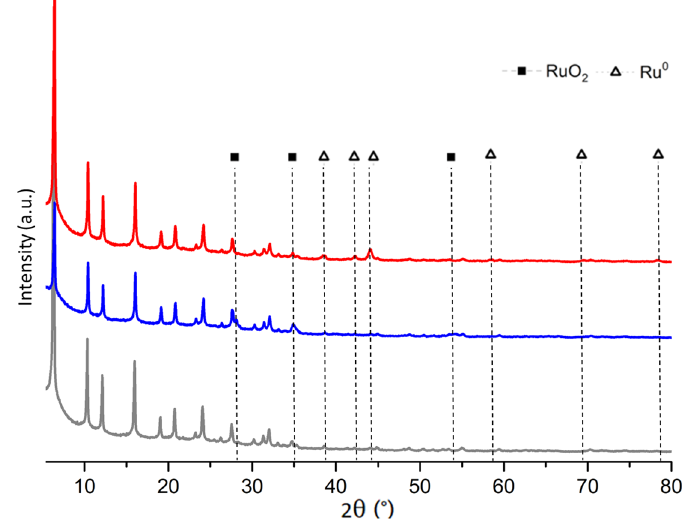
Figure 1. XRD patterns acquired for CsUSY support (in gray) and 3Ru/CsUSY catalyst after calcination (in blue) and after reduction (in red).